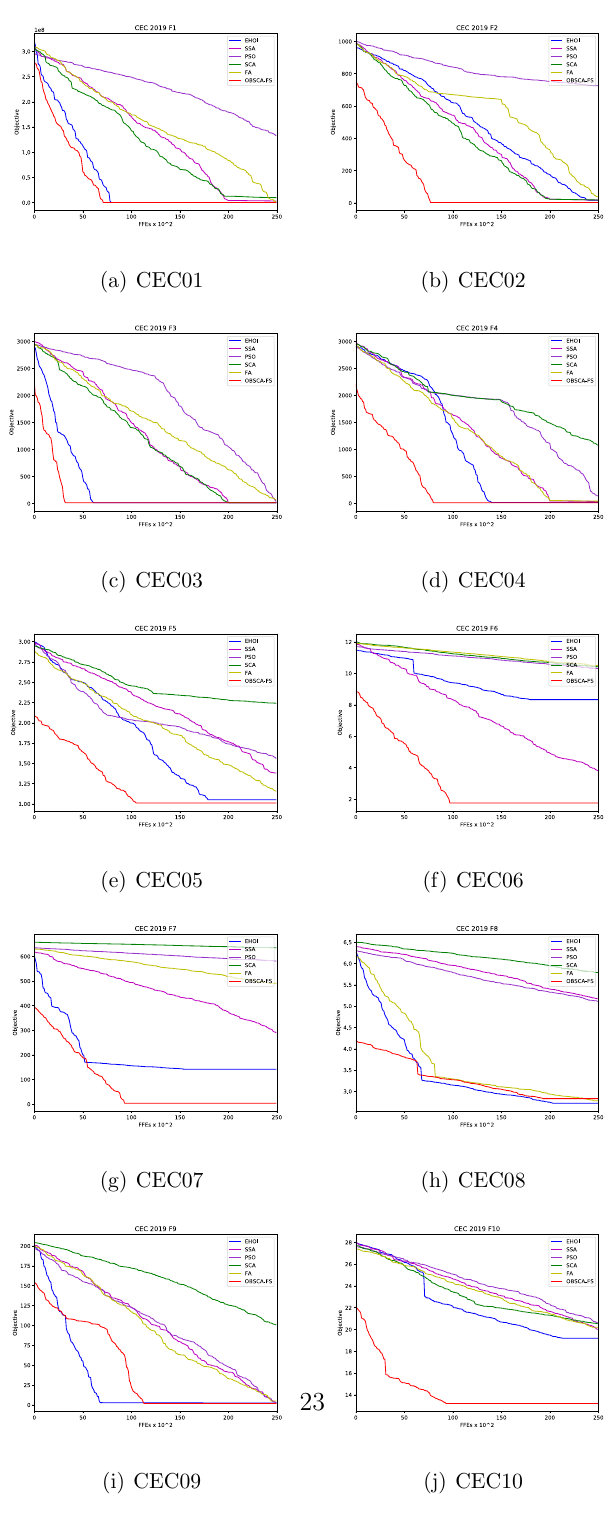
Figure 1. Convergence speed graphs of the 10 CEC 2019 benchmark functions as direct comparison between proposed OBSCA-FS and relevant